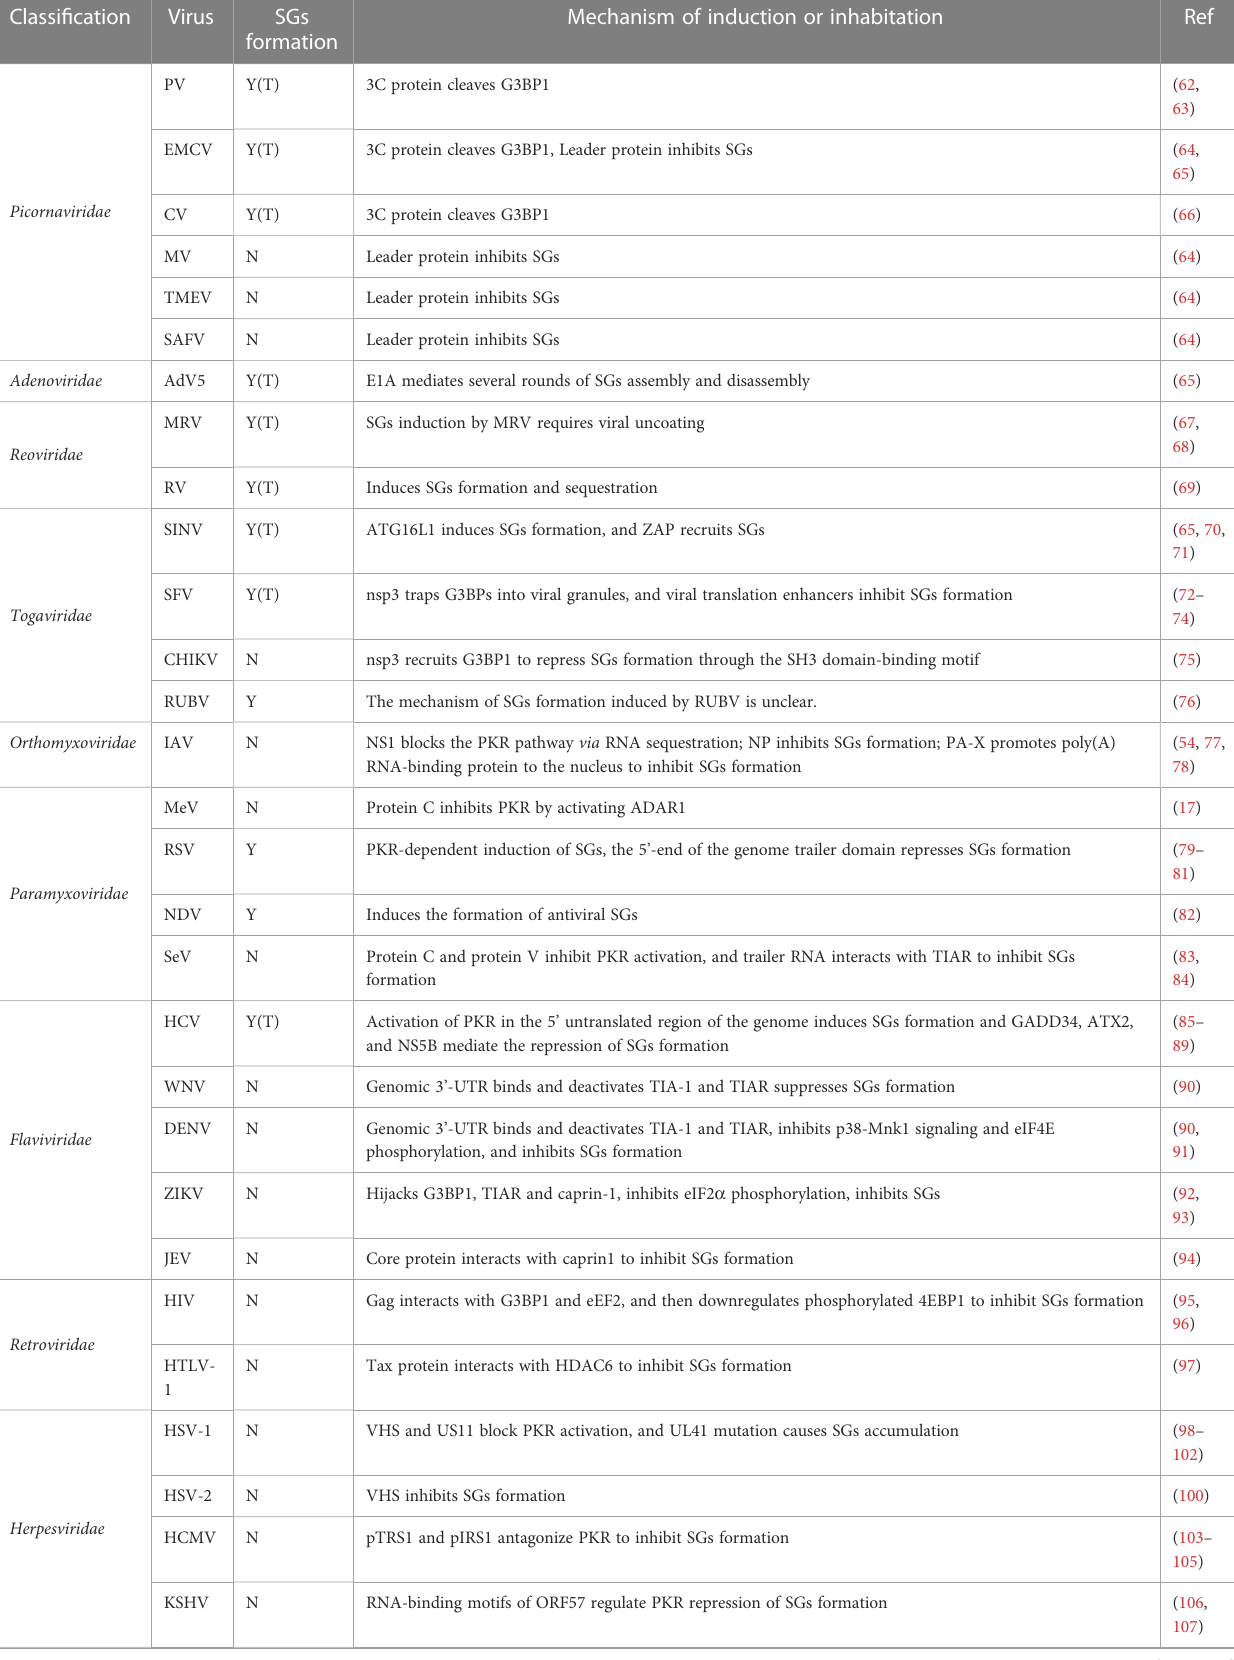
TABLE 1 Viral infection and SGs